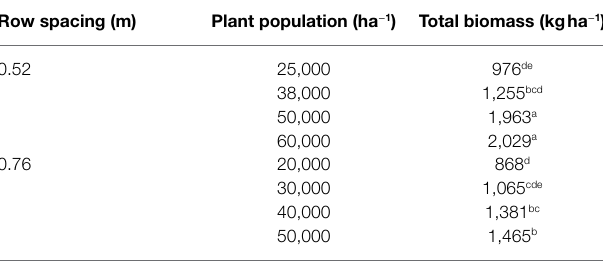
TABLE 3 | Effect of row spacing and plant population on total biomass at the sixth-leaf collar (V6) development stage across season. Row spacing (m)